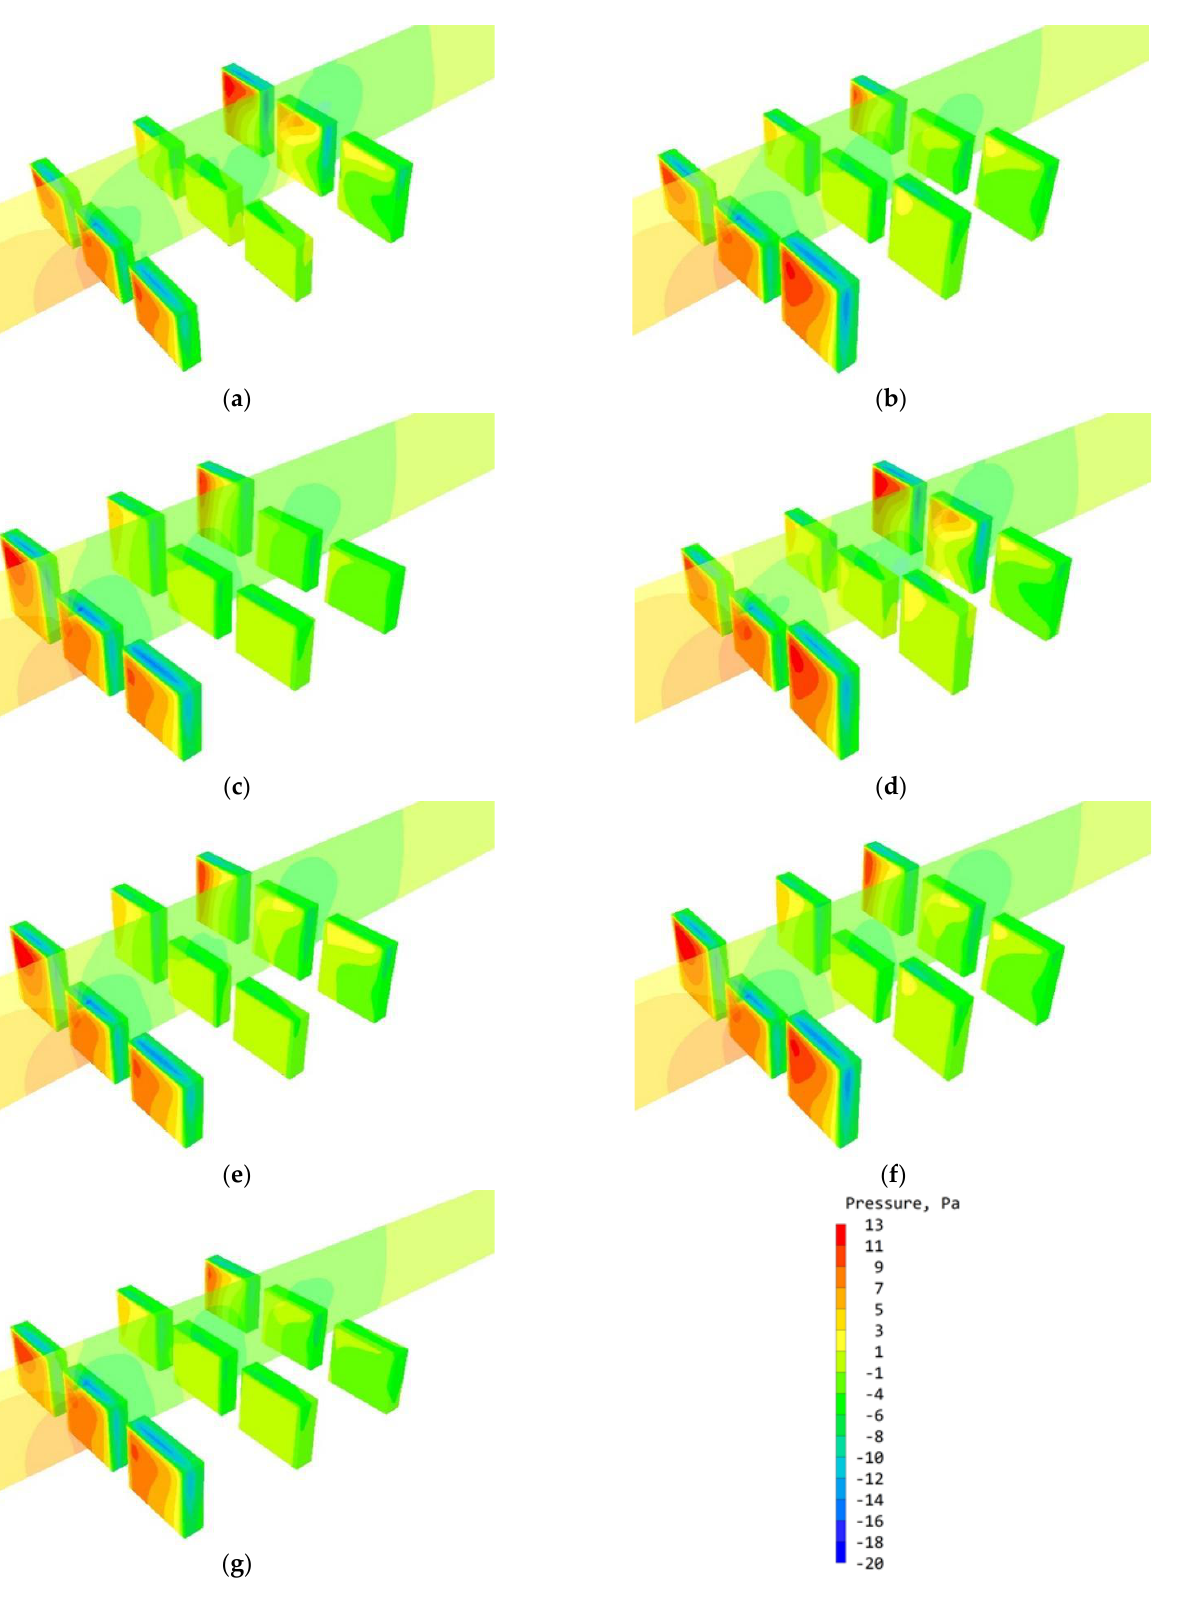
Figure 10. Three-dimensional wind pressure map of seven building distribution patterns. ( a ) North side high (1-N), ( b ) east side high (1-E), ( c ) west side high (1-W), ( d ) east and north side high (2-EN), ( e ) west and north side high (2-WN), ( f ) east–west and north side high (3-EWN), and ( g ) uniform building height